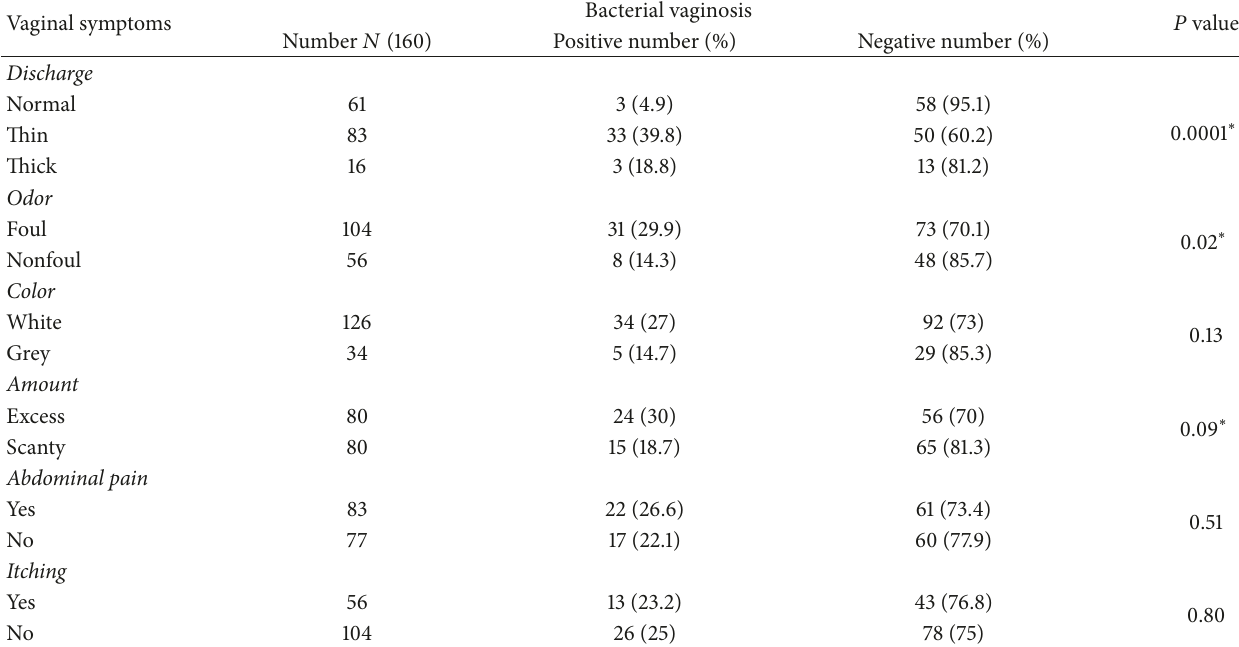
Table 5: Sample distribution on the basis of symptoms.